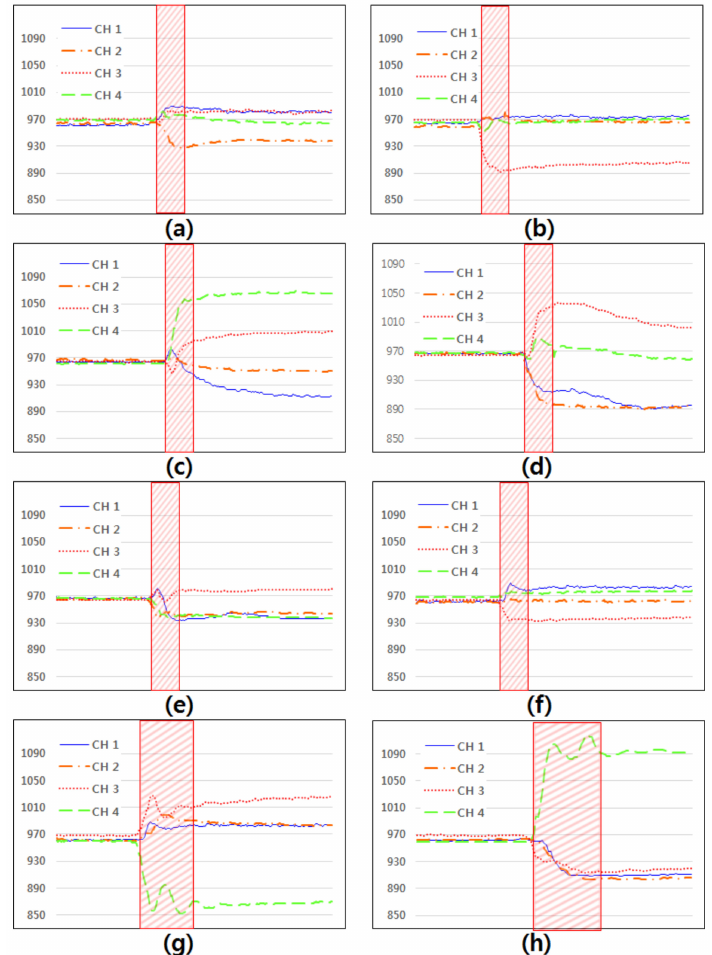
Figure 5. Changes in each of the signals ( a – h ) produced during the eight motions shown in Figure 4. The shaded areas indicate when each movement was made.